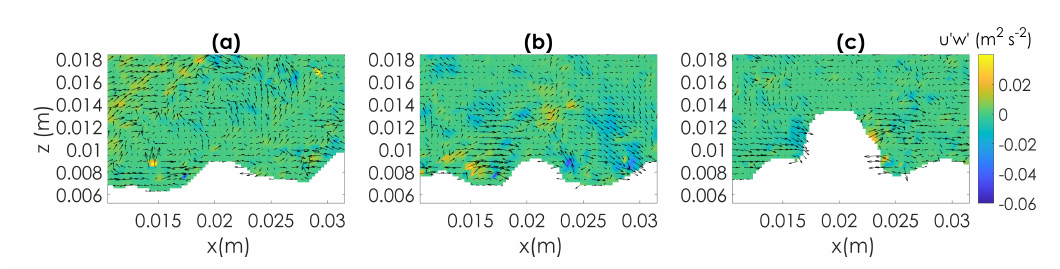
Figure 17. Instantaneous Reynolds shear stress maps with vectors superimposed representing velocity fluctuations obtained for Type C (Particle 27, Test T2) for the sequence of three PIV images reported in Figure 16. (For clarity only 1 out of 2 vectors are depicted.) ( a ) Instantaneous Reynolds stresses and particle at rest. ( b ) Instantaneous Reynolds stresses with particle at rest while moving particle is approaching. ( c ) Instantaneous Reynolds stresses during particles’